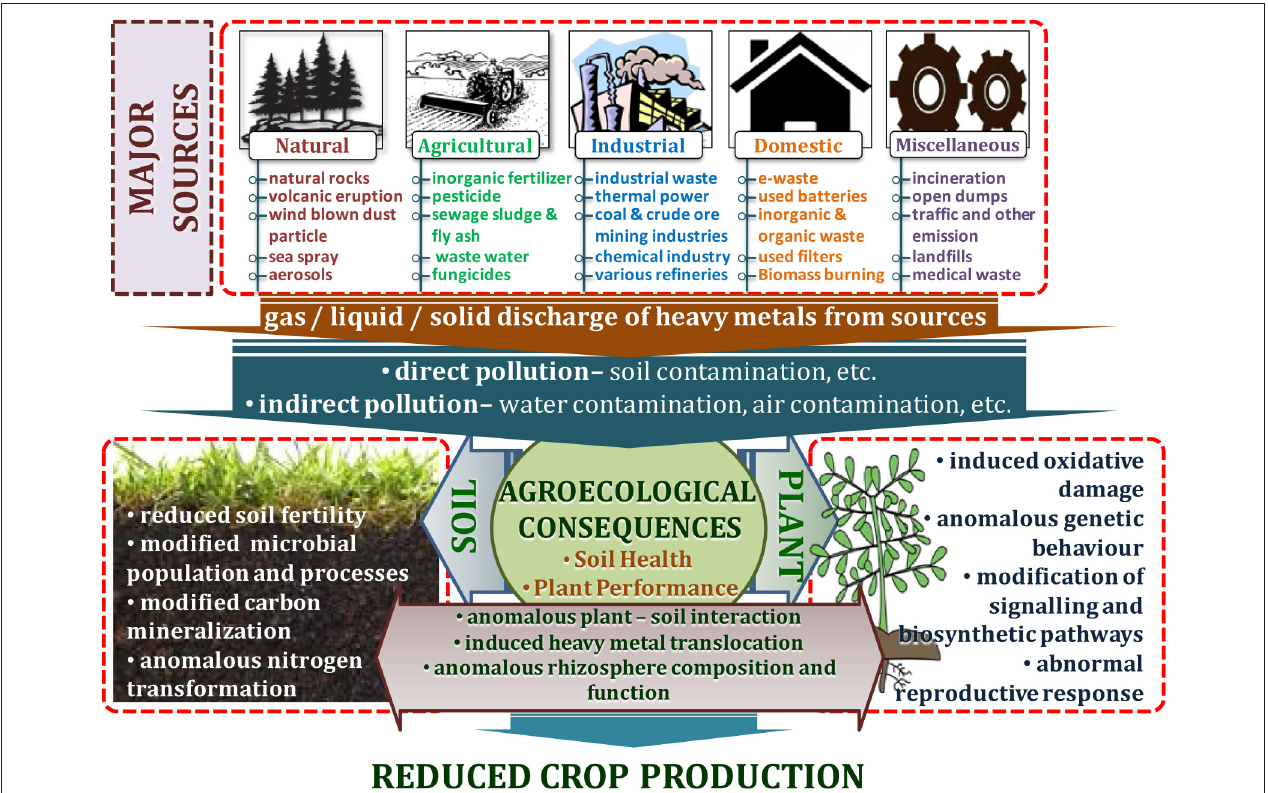
FIGURE 1 | Overview of sources of heavy metal pollution and its agroecological